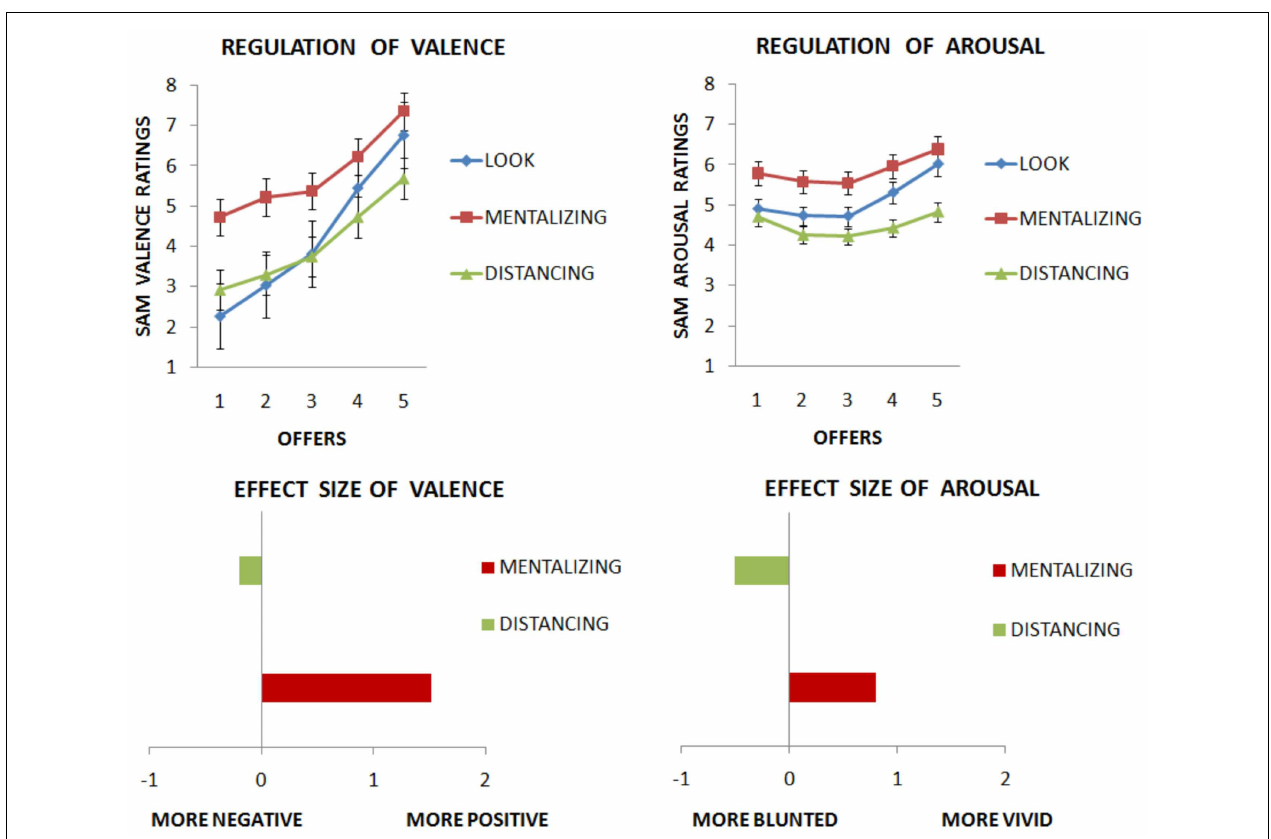
but not when they took the distance from them. Arousal (graph on the right) was affected by strategies. (Lower part) Results from size effects of valence and arousal are shown. See text for further